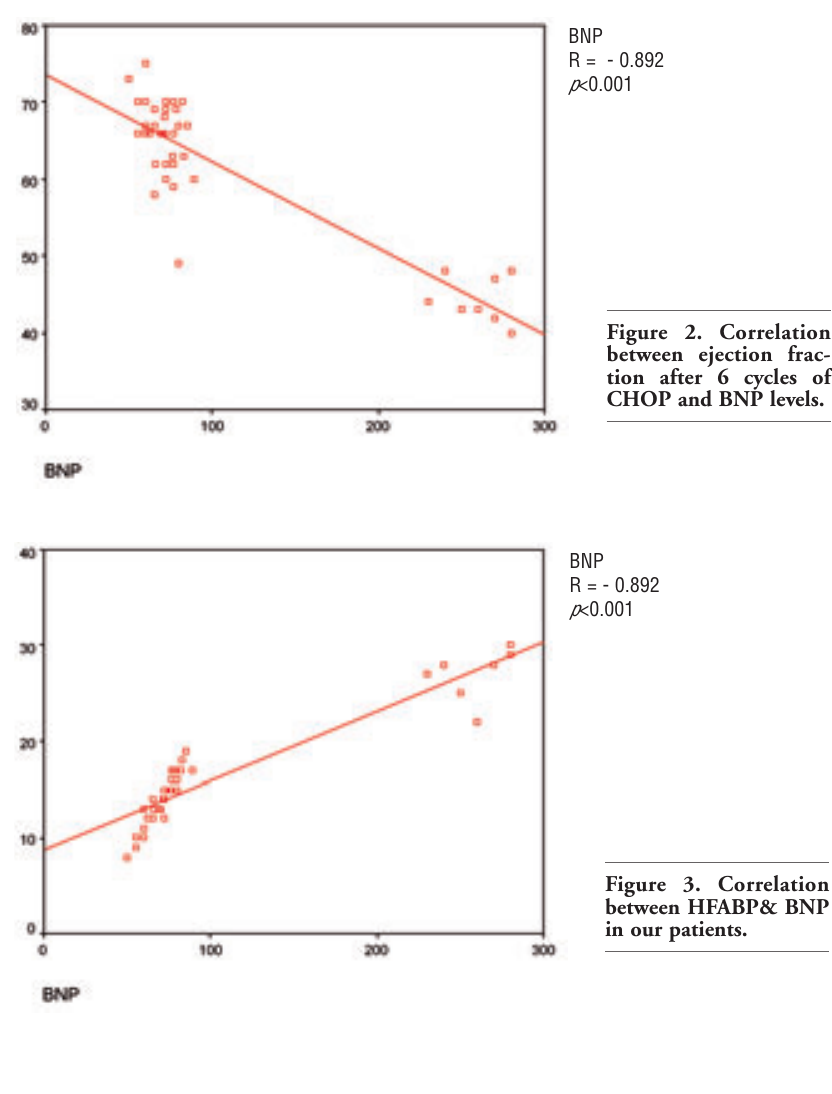
Figure 3. Correlation between HFABP& BNP in our patients.